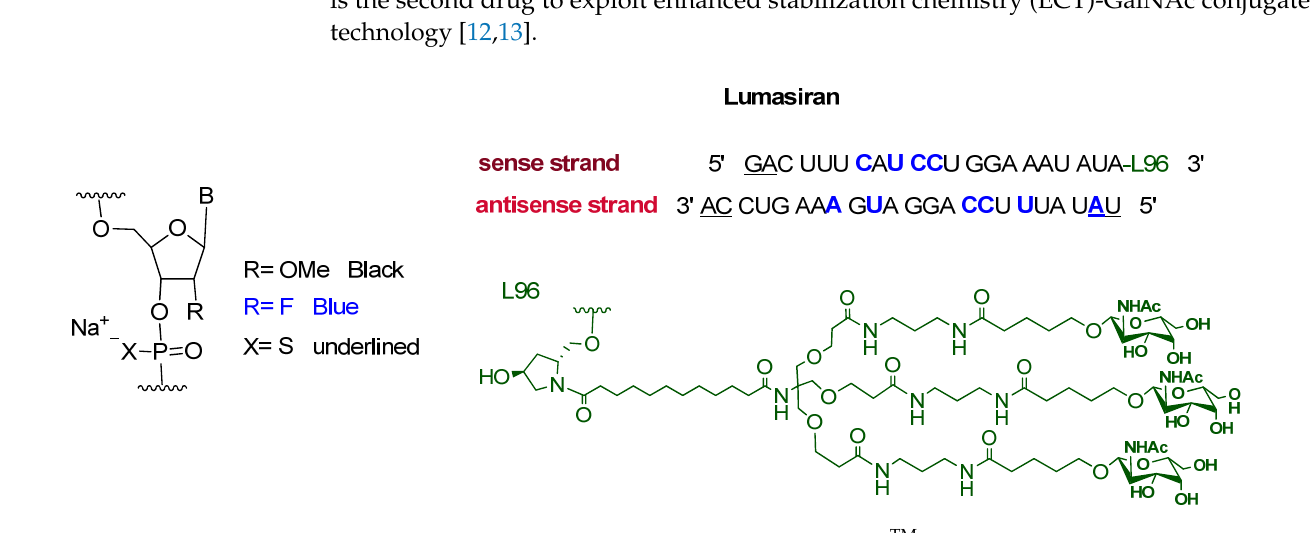
Table 3. FDA ‐ approved peptides between 2016 and 2020.